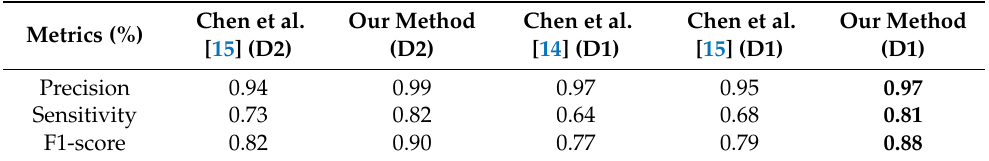
Table 9. Comparison of our method with existing methods.